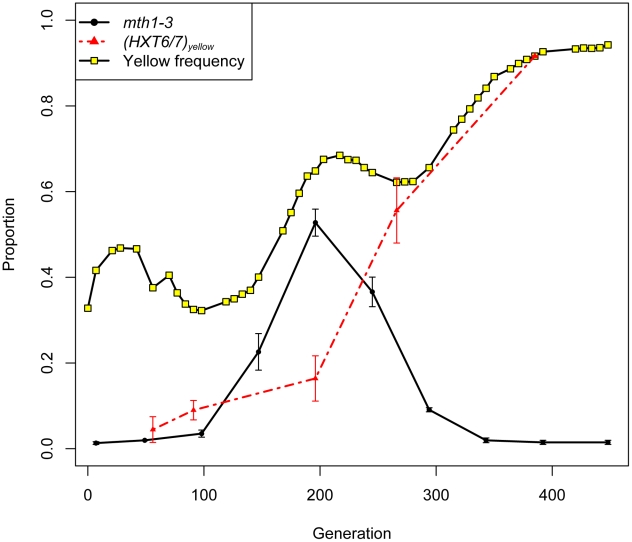
Allele frequencies of mth1-3 and HXT6/7 amplification in the yellow subpopulation.Over the course of the experiment, mth1-3 transiently increases in frequency but gets outcompeted by clones carrying the HXT6/7 amplification by the end of the experiment. Error bars are +/− standard error of the mean of three biological replicate experiments. HXT6/7 data are from [25], plotted as a proportion of the yellow subpopulation.